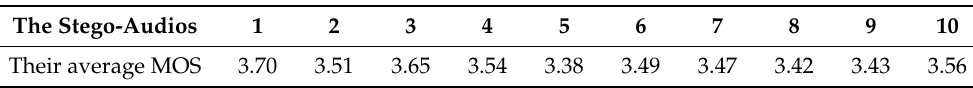
Table 8. The average MOS of ten randomly selected stego-audios generated by this model without a post-processing